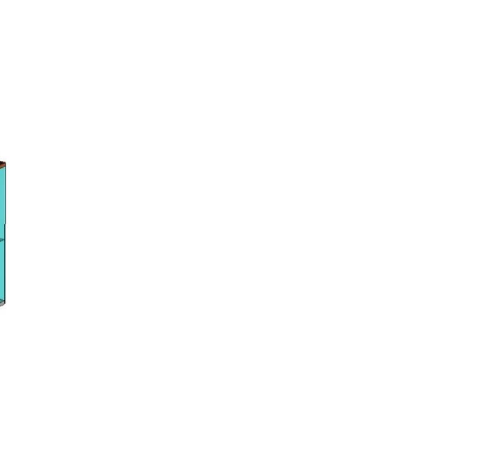
Figure 9. ( a ) The proposed unit-cell composed of two layers, the middle layer is a metallic patch located on the Silicon layer ( h 1 = 28 µm ) as a dielectric spacer, and the top layer is graphene patch located on Alumina layer ( h 3 = 0 . 2 µm ). Another Silicon layer ( h 2 = 32 µm ) is located between the Alumina and metal slot layer. ( b )The cell-cluster composed of 6 × 6